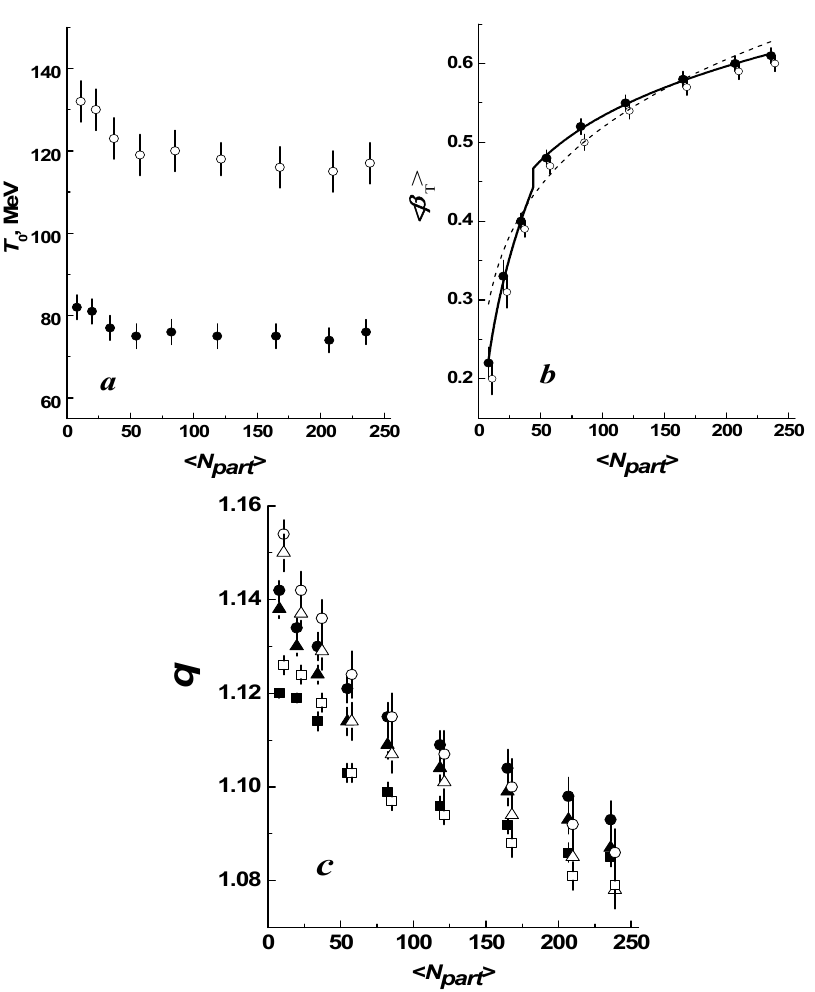
(cid:10) (cid:11) N part Figure 4. The same as Figure 3, but obtained in Ref. [24] for dependencies of the extracted Figure 4. The same as Figure 3, but obtained in Ref. [24] for 〈𝑁 (cid:3043)(cid:3028)(cid:3045)(cid:3047) 〉 dependencies of the extracted √ s nn = 5.44 TeV. The dashed and solid curves parameters T 0 ( a ), β T ( b ) , and q ( c ) in Xe+Xe collisions at parameters T 0 ( a ), 〈𝛽 (cid:3021) 〉 ( b ) , and q ( c ) in Xe+Xe collisions at (cid:3493)𝑠 (cid:3041)(cid:3041) = 5.44 TeV. The dashed and solid in panel ( b ) are minimum χ 2 fits by the simple (single)-power and two-power functions, respectively, curves in panel ( b ) are minimum χ2 fits by the simple (single)-power and two-power functions, (cid:10) (cid:11) respectively, of the 〈𝛽 (cid:3021) 〉 versus 〈𝑁 (cid:3043)(cid:3028)(cid:3045)(cid:3047) 〉 dependence, obtained using thermodynamically consistent N part of the β T versus dependence, obtained using thermodynamically consistent Tsallis function Tsallis function with transverse flow (Equation (5)). For better visibility, the data (open symbols) with transverse flow (Equation (5)). For better visibility, the data (open symbols) extracted using extracted using thermodynamically non-consistent Tsallis function with transverse flow (Equation thermodynamically non-consistent Tsallis function with transverse flow (Equation (4)) are shifted by (cid:10) (cid:11) (4)) are shifted by +3 units along the positive direction of the 〈𝑁 (cid:3043)(cid:3028)(cid:3045)(cid:3047) 〉 axis. N part +3 units along the positive direction of the